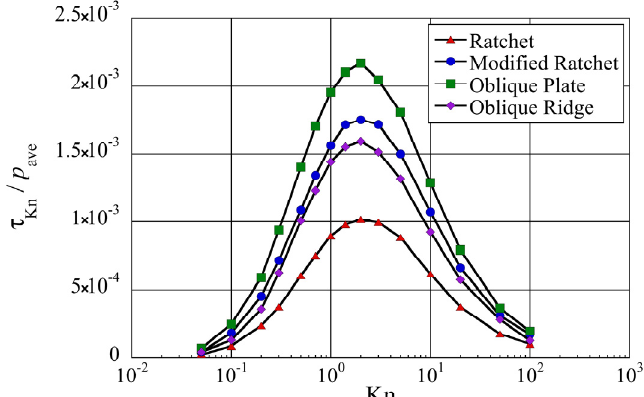
Figure 10. Net tangential Knudsen stresses, i.e., propulsive forces per unit area, at different Knudsen numbers for different surface microstructures.